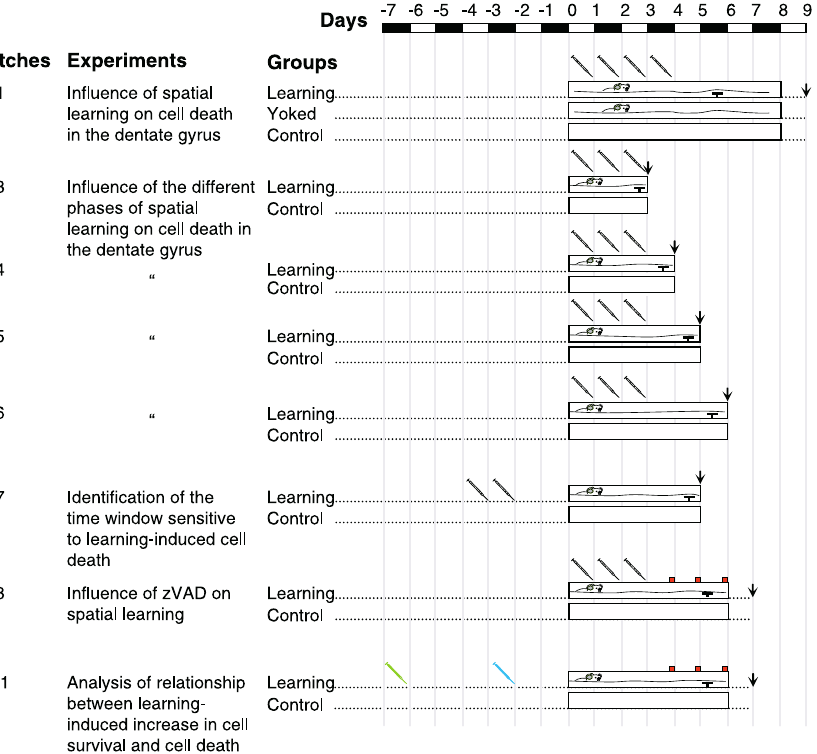
Figure 2. Schematic Representation of the Main Experiment Syringes represent XdU BrdU (gray), IdU (green), and CldU (blue) injections. Black arrows represent the time of sacrifice. Red squares represent intracerebroventricular infusions (zVAD or Vehicle).